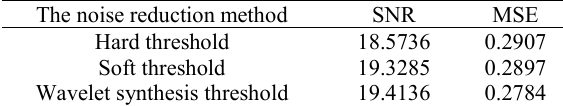
Table 2 SNR and MSE from the de-noised signal in simulation The noise reduction